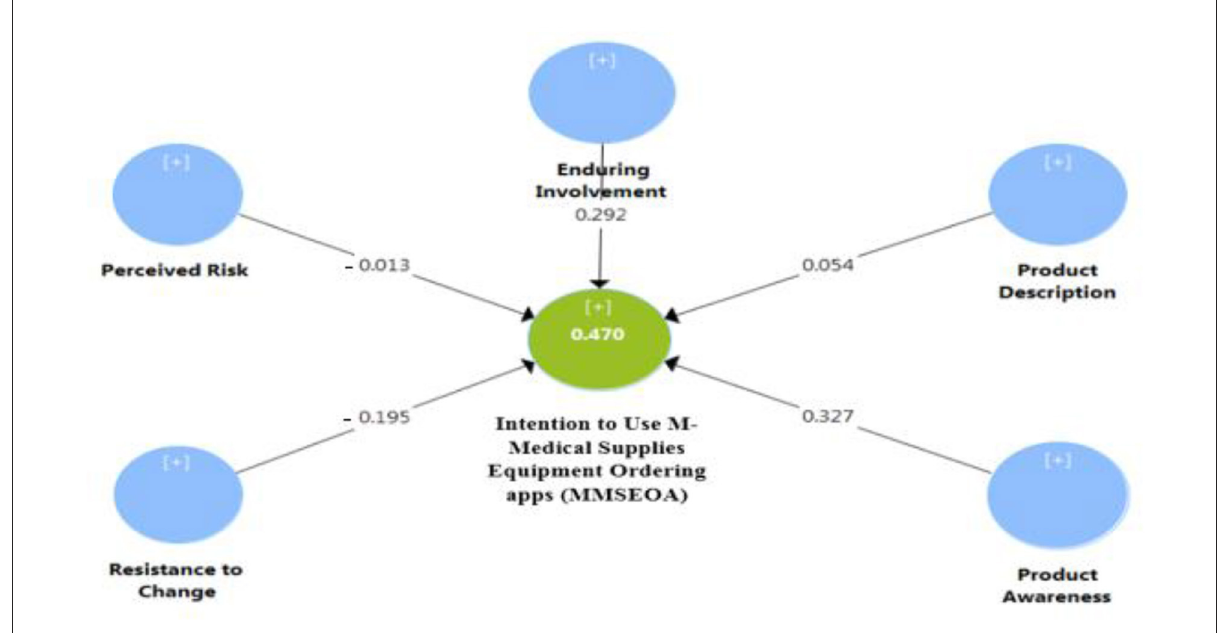
FIGURE2 Model path findings.